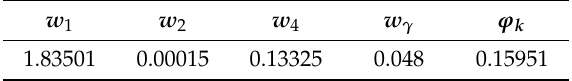
Table 3. Material-specific parameters for the transition function δ HS